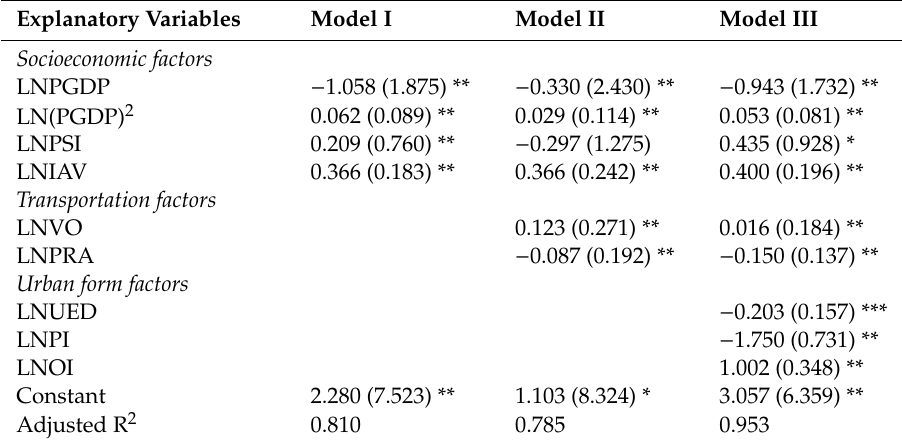
Table 3. Similar to Table 2, but for the near-surface NO 2